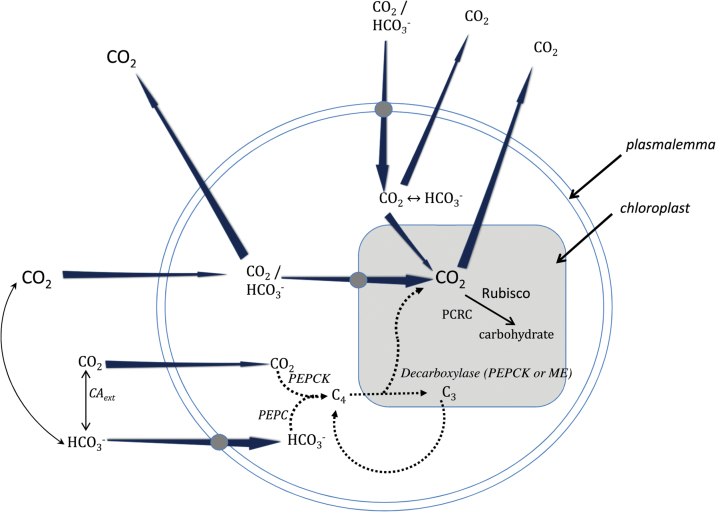
A schematic model for inorganic carbon transport, and CO2 accumulation and leakage in eukaryotic algal cells. The model incorporates the possibilities for DIC transport at the plasmalemma and/or chloroplast envelope as well as a putative C4-like mechanism. Active transport processes (shown by the shaded boxes) can be of CO2 or HCO3−. No attempt has been made to show the roles of the various internal CAs in the different compartments. For this the reader is referred to Giordano et al. (2005). Redrawn after Giordano et al. 2005. CO2 concentrating mechanisms in algae: mechanisms, environmental modulation, and evolution. Annual Review of Plant Biology 6, 99–131.